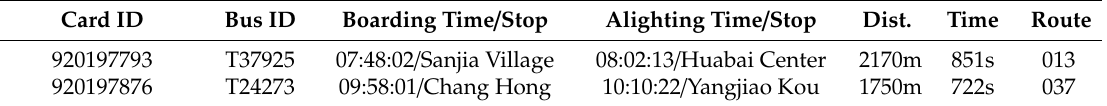
Table 4. Examples of the passengers’ trip data.